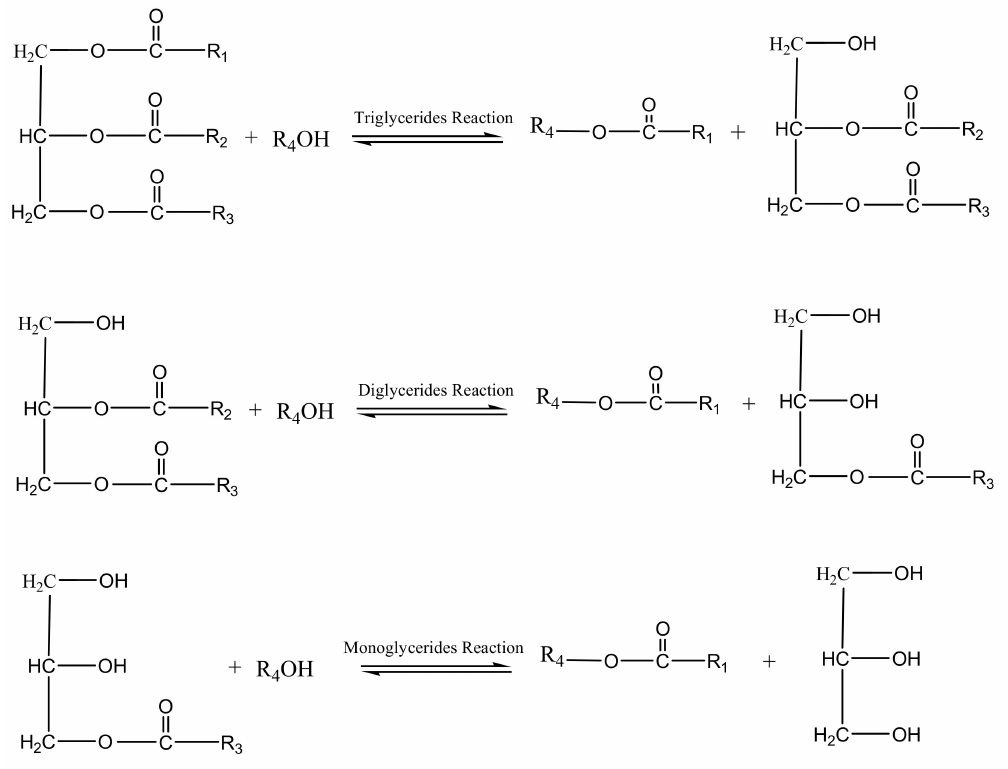
Figure 7. Three-step equation for the transesterification reaction